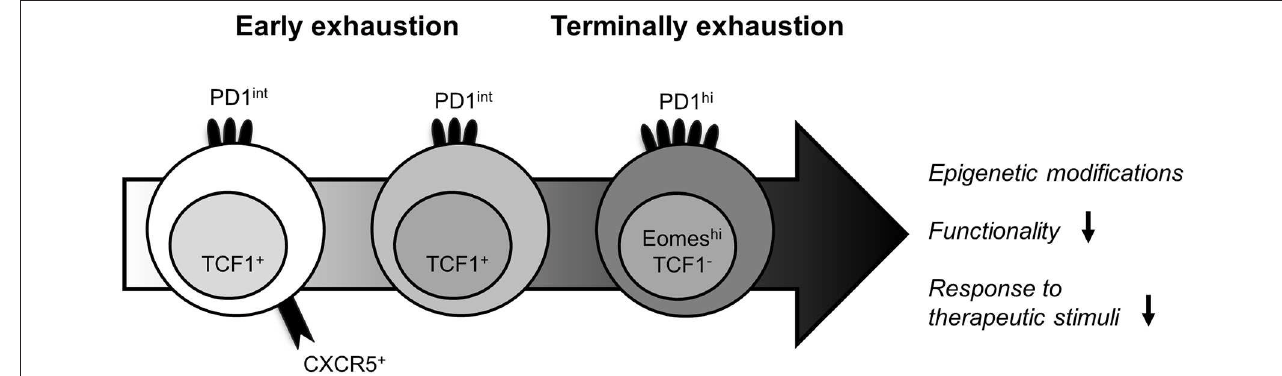
FIGURE 1 | Heterogeneity of exhausted LCMV-specific CD8 + T cells. The identification of functionally distinct T-cell subpopulations within exhausted LCMV-specific CD8 + T cells has enabled the definition of their lineage dynamics. Despite the epigenetic fingerprint of T-cell exhaustion, the expression patterns of several phenotypical and transcriptional markers can discriminate between less exhausted and terminally exhausted LCMV-specific CD8 + T cells. While the early differentiated LCMV-specific CD8 + T-cell subpopulation is defined by co-expression of PD1, CXCR5, and TCF1 and provides a strong response to therapeutic stimuli, the more differentiated PD1 int TCF1 + LCMV-specific CD8 + T-cell subpopulation still harbors some effector function. In contrast, the terminally exhausted PD1 hi , Eomes hi LCMV-specific CD8 + T-cell population exhibit a more severely impaired functionality and is unresponsiveness to